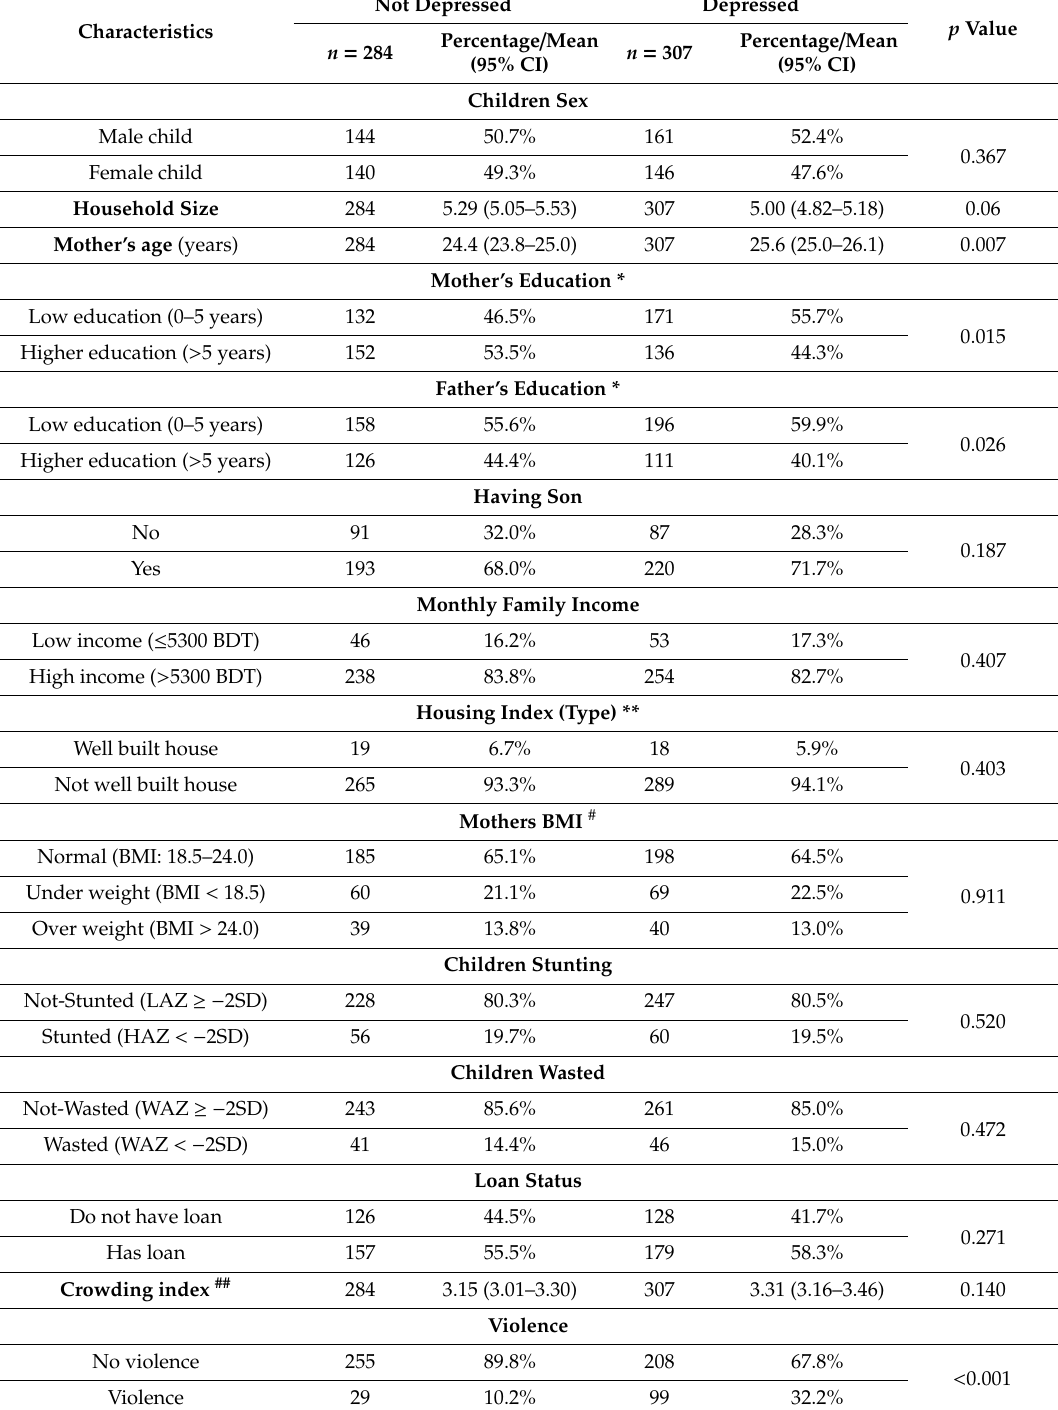
Table 1. Socio-demographic characteristics by depression status of the